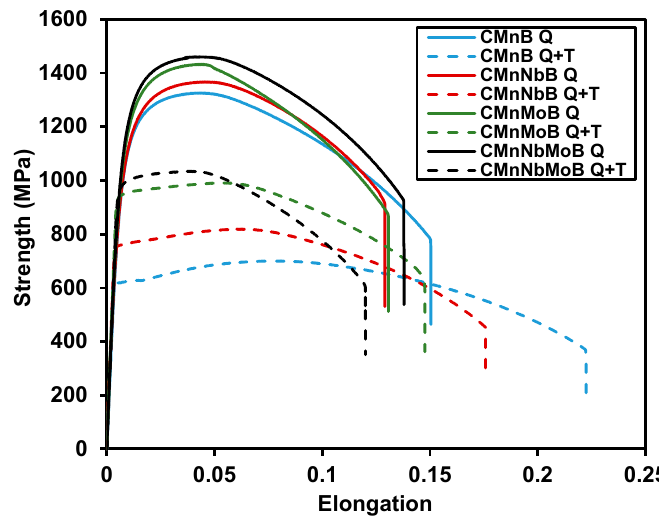
Figure 10. Tensile curves in Q and Q + T cycles for all steel grades. Table 3. Tensile properties measured before and after tempering treatment for all the chemistries (YTR: yield-to-tensile ratio).